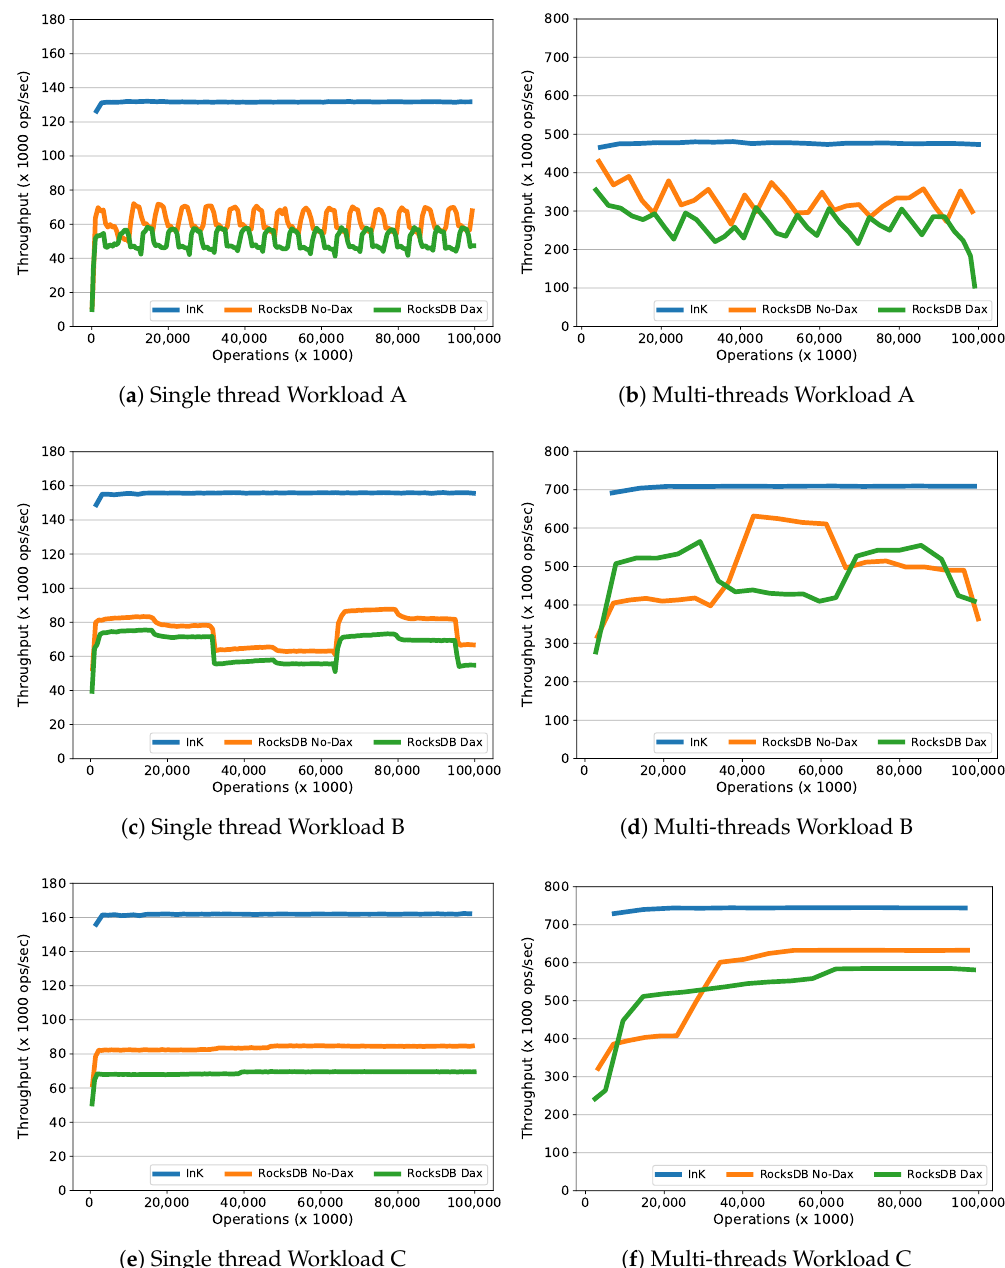
Figure 11. Throughput comparisons of workloads with Zipfian